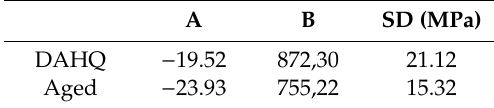
Table 3. Fitting parameters of stress vs. number of cycles ( S-N )